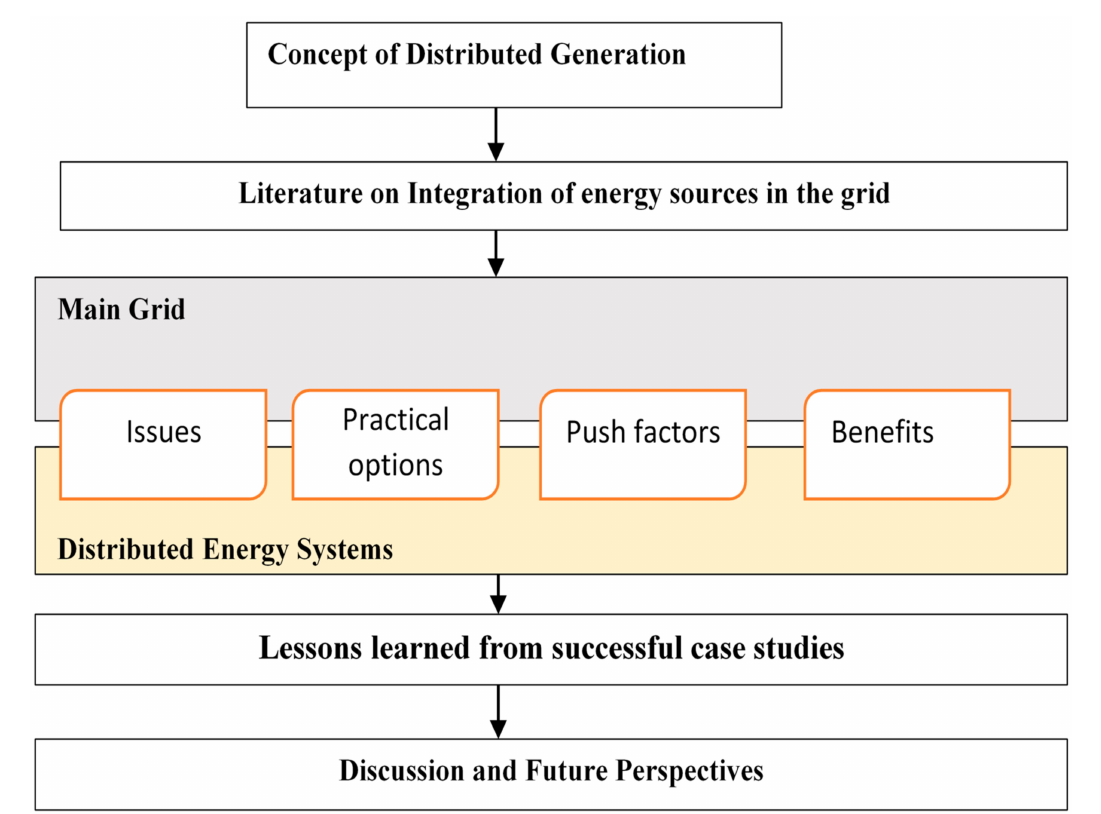
Figure 1. Illustration of the structure of the review